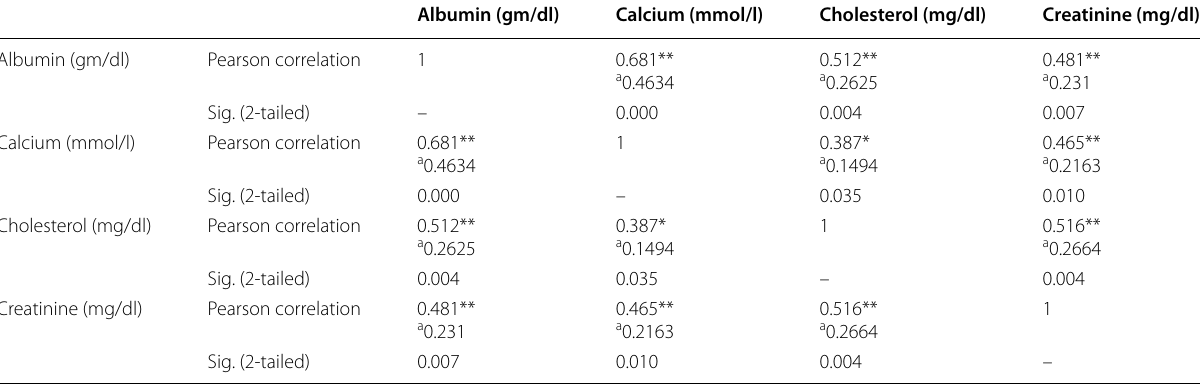
** Correlation is significant at the 0.01 level (2-tailed) * Correlation is significant at the 0.05 level (2-tailed) a R 2 value was obtained from the graph